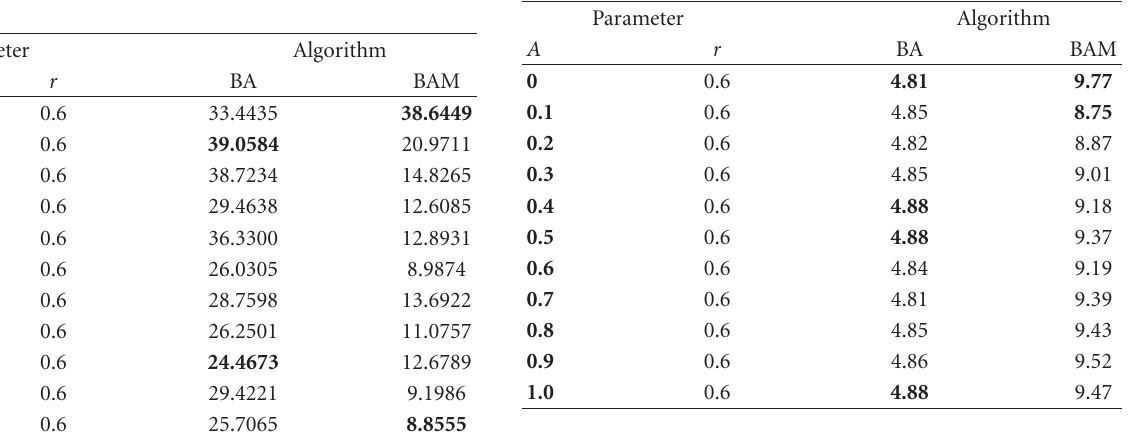
Table 13: Average CPU time on UCAV path planning problem on di ff erent A . The numbers shown are the minimum average CPU time (Sec) consumed by BA and BAM